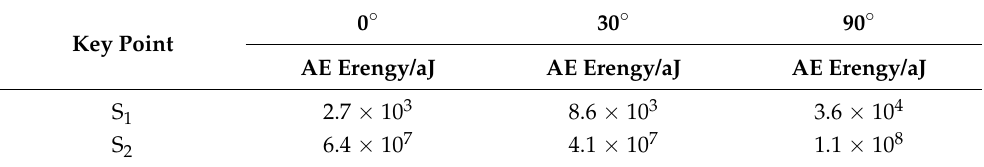
Table 5. AE energy level for different bedding angle under saturated state.